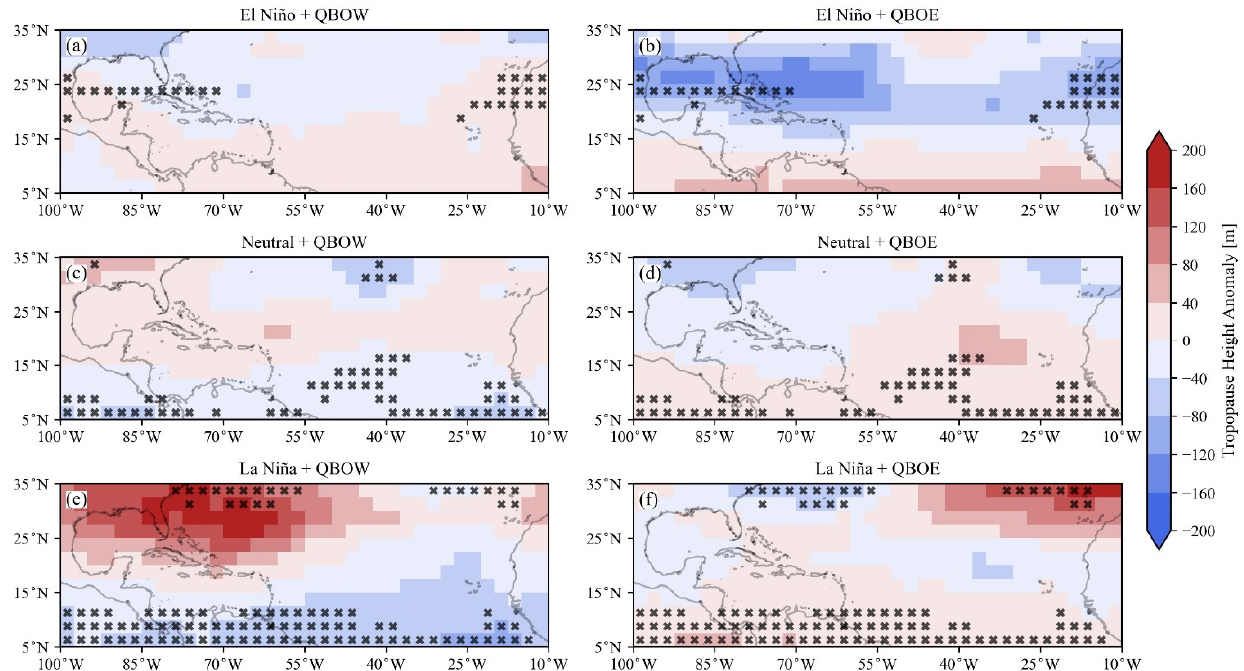
Figure 6. ( a ) El Niño + QBOW, ( b ) El Niño + QBOE, ( c ) Neutral + QBOW, ( d ) Neutral + QBOE, ( e ) La Niña + QBOW, and ( f ) La Niña + QBOE. Same as Figure 3 for the NCEP-NCAR tropopause height anomalies for the season JJASON for the years classified by ENSO and QBO phases during the 1953–2020 period. The crosses show the regions where the p -value of the Mann-Whitney U test is lower than 0.1.